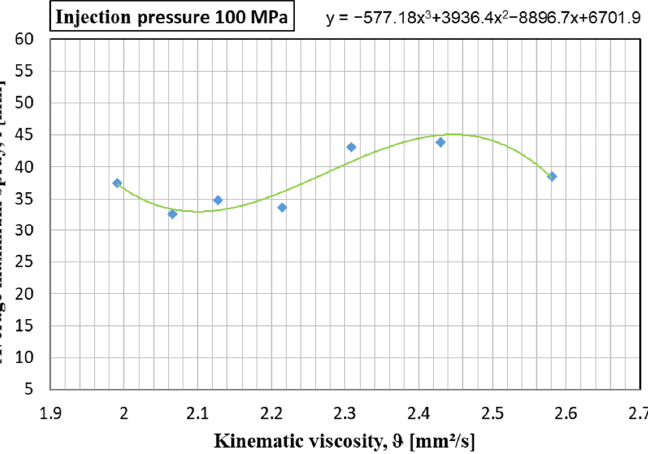
Figure 10. Maximum range of spray tip with the trend line determined for injection pressure of 100 MPa.